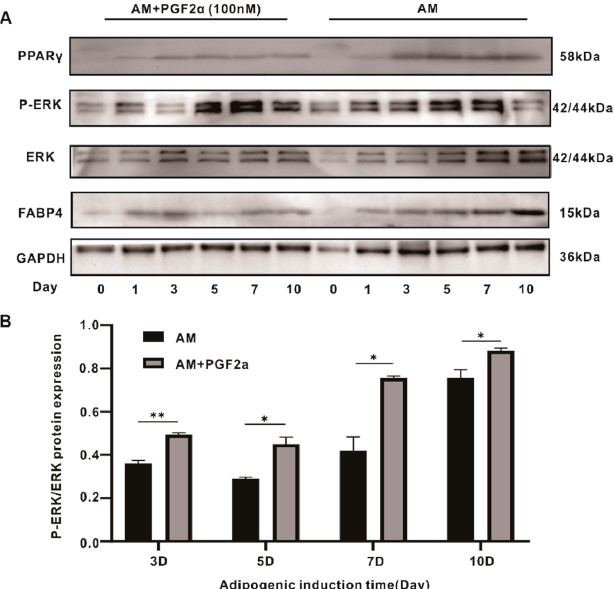
Figure 4. ERK phosphorylation participated in the anti-adipogenic effects caused by PGF2 α . ( A ) The WB results for the ERK, p-ERK, PPAR γ , and FABP4 along with the time taken to induce the effects (10 days). ( B ) The degree of P-ERK/ERK protein expression at different time points. Data are presented as the means ± SEMs ( n = 3) (*, p -value < 0.05; **, p -value < 0.01). AM: adipogenesis induction medium.